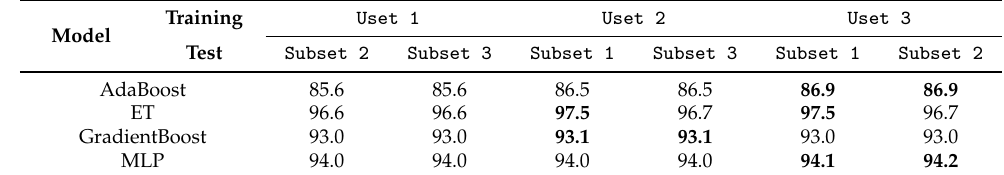
Table 6. Classification results of the four selected models on different training and test data subsets. The values represent the AA in%. The bold value represents the best subset combination classification